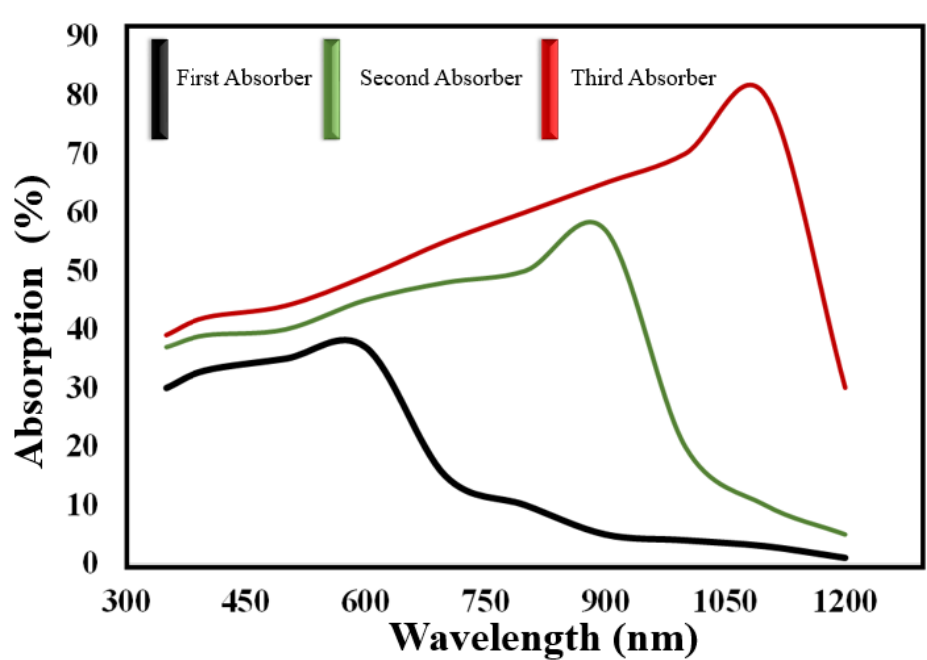
Figure 7. Absorption spectrum coverage against the wavelength.